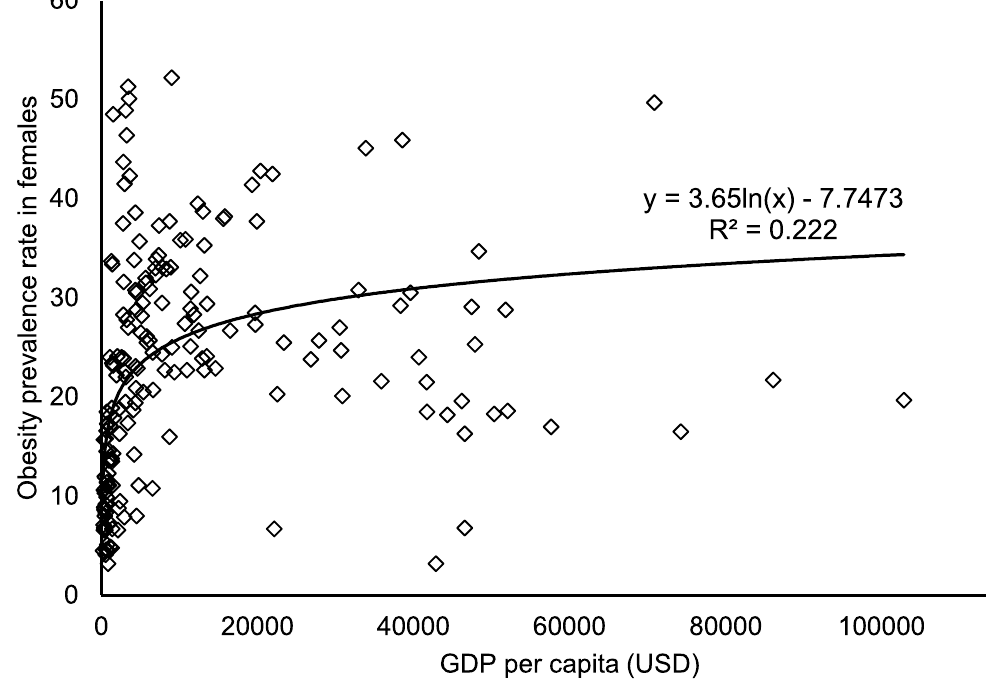
Figure 1. Relationship between GDP per capita and sex-specific obesity prevalence